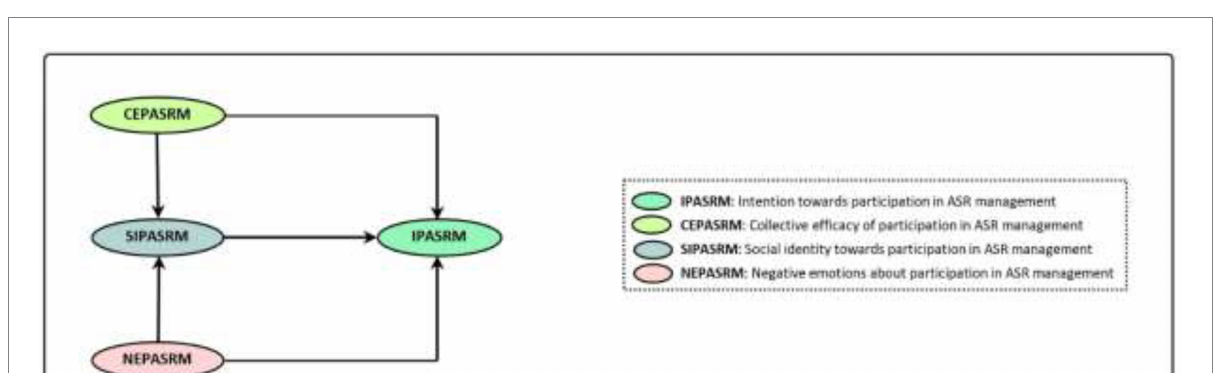
FIGURE 1 The dual-pathway model of collective action (Bamberg et al., 2015).